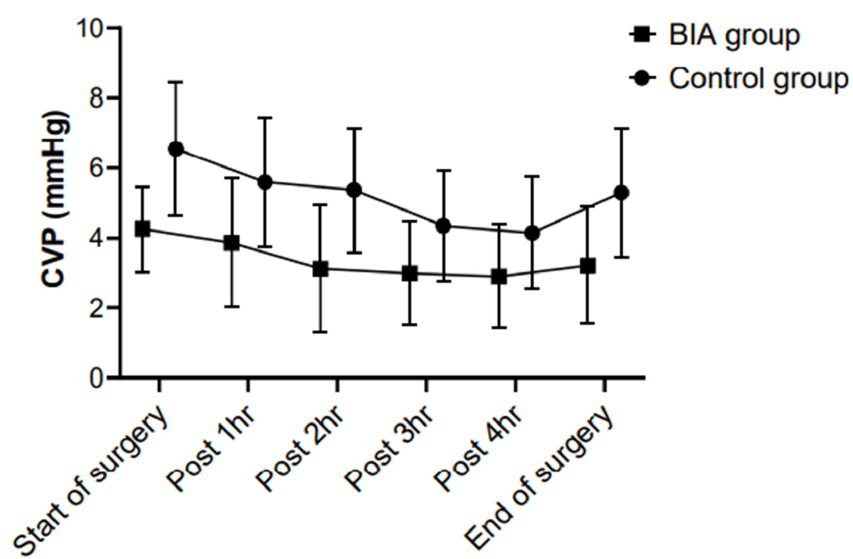
Figure 2. Between-group comparisons of the CVP during hepatic resection. The CVP was significantly